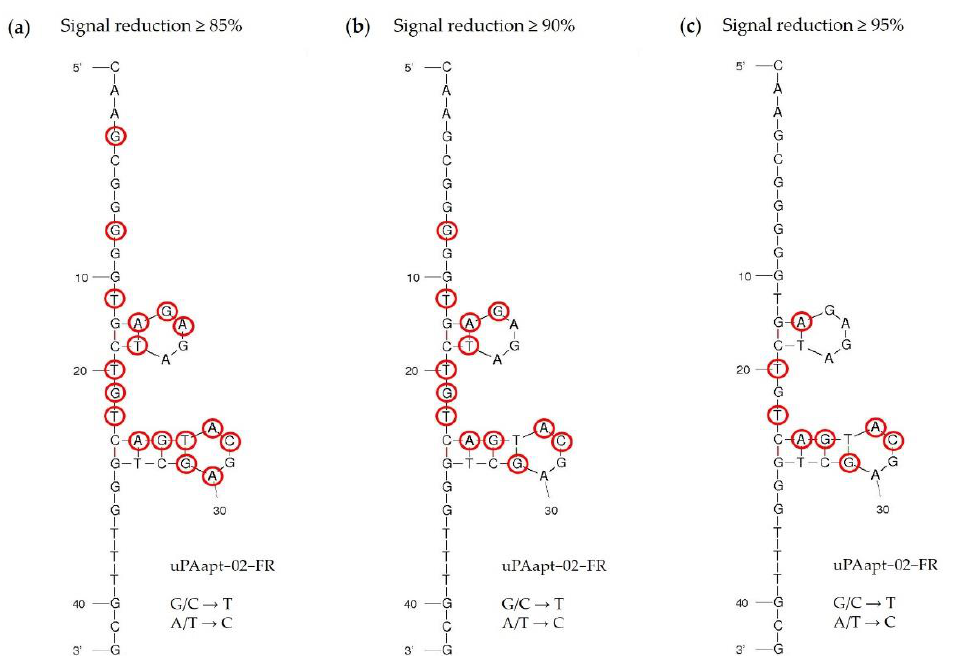
10 of 17 Figure 6. Sensitivity of the aptamer-based sandwich assay for detection of HMW-uPA by uPAapt−08−FR and uPAapt−02−FR in BPs -T and spiked urine samples. ( a ) Comparison of the ap- tamer-based sandwich assay in BPs-T and spiked urine at a constant concentration of 40 pmol HMW-uPA per well. ( b ) Determination of the sensitivity of the aptamer-based sandwich assay. Cal- ibration curves were obtained by plotting the measured relative fluorescence unit as a function of the HMW-uPA concentration in a standard series. A linear dependence was found between the concentration of HMW-uPA and the measured relative fluorescence units [RFU]. The relative fluo- rescence is given as the average value of three independent experiments each with three technical replicates and was measured using the EnVision ® 2105 multimode plate reader. Error bars represent the standard deviation. NTC = No Target Control, HMW = HMW-uPA. Number of records n = 3.